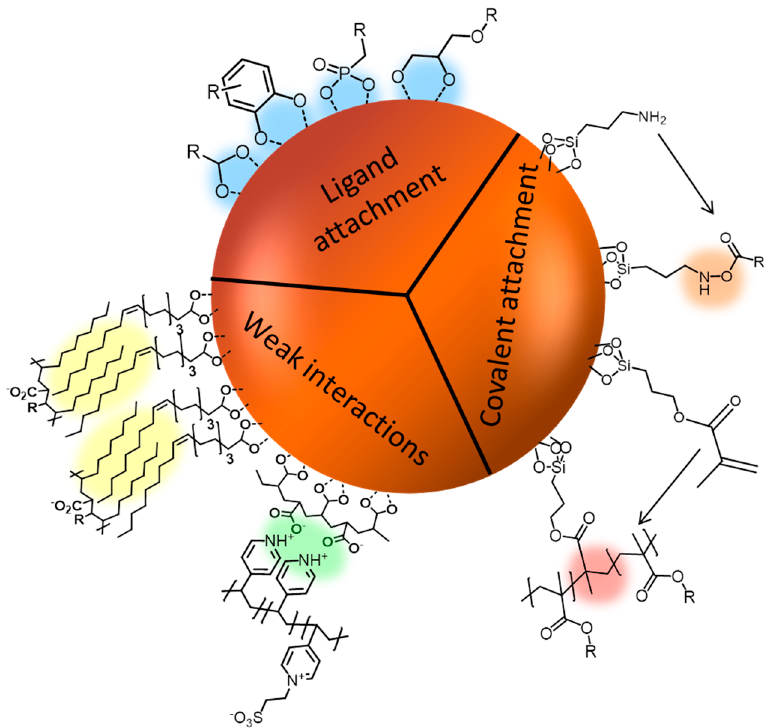
Figure 4. Schematic representation of applied immobilization techniques for polyzwitterions at the surface of magnetic nanoparticles (MNPs).